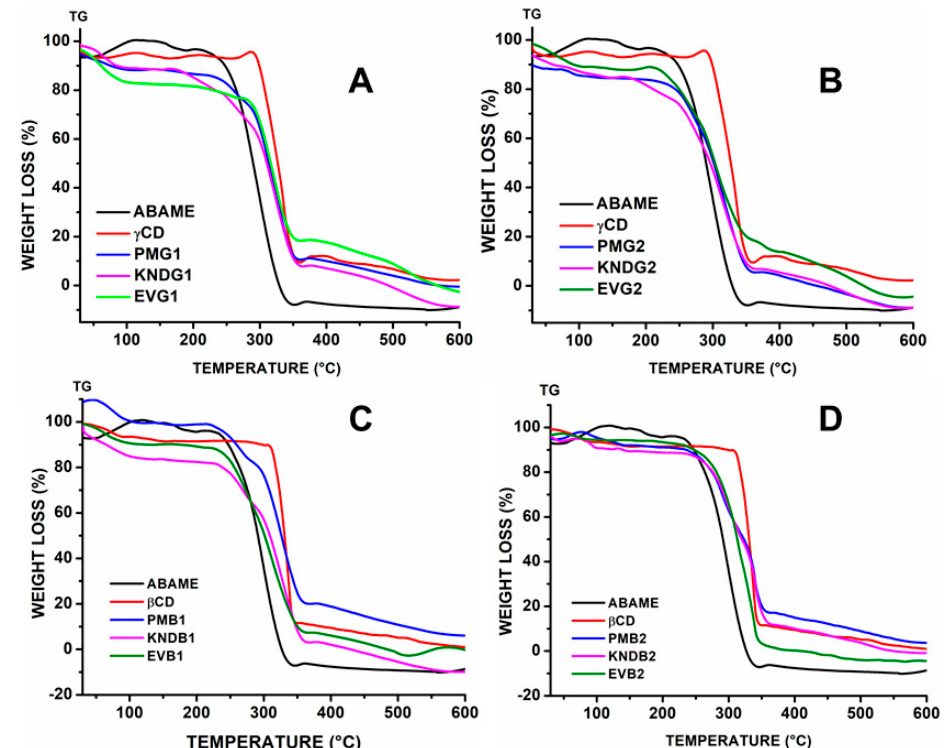
Figure 9. Thermogravimetry curves of individual compounds, namely α , β -amyrenone (ABAME), β -cyclodextrin ( β CD) and γ -cyclodextrin ( γ CD), as well as inclusion complexes (ICs). ICs prepared with ABAME and β CD at 1:1 ( A ) and 2:1 ( B ) molar ratios using physical mixture (PMB1 and PMB2), kneading (KNDB1 and KNDB2), and rotary evaporation (EVB1 and EVB2), respectively. ICs prepared with ABAME and γ CD at 1:1 ( C ) and 2:1 ( D ) molar ratios using physical mixture (PMG1 and PMG2), kneading (KNDG1 and KNDG2), and rotary evaporation (EVG1 and EVG2), respectively.